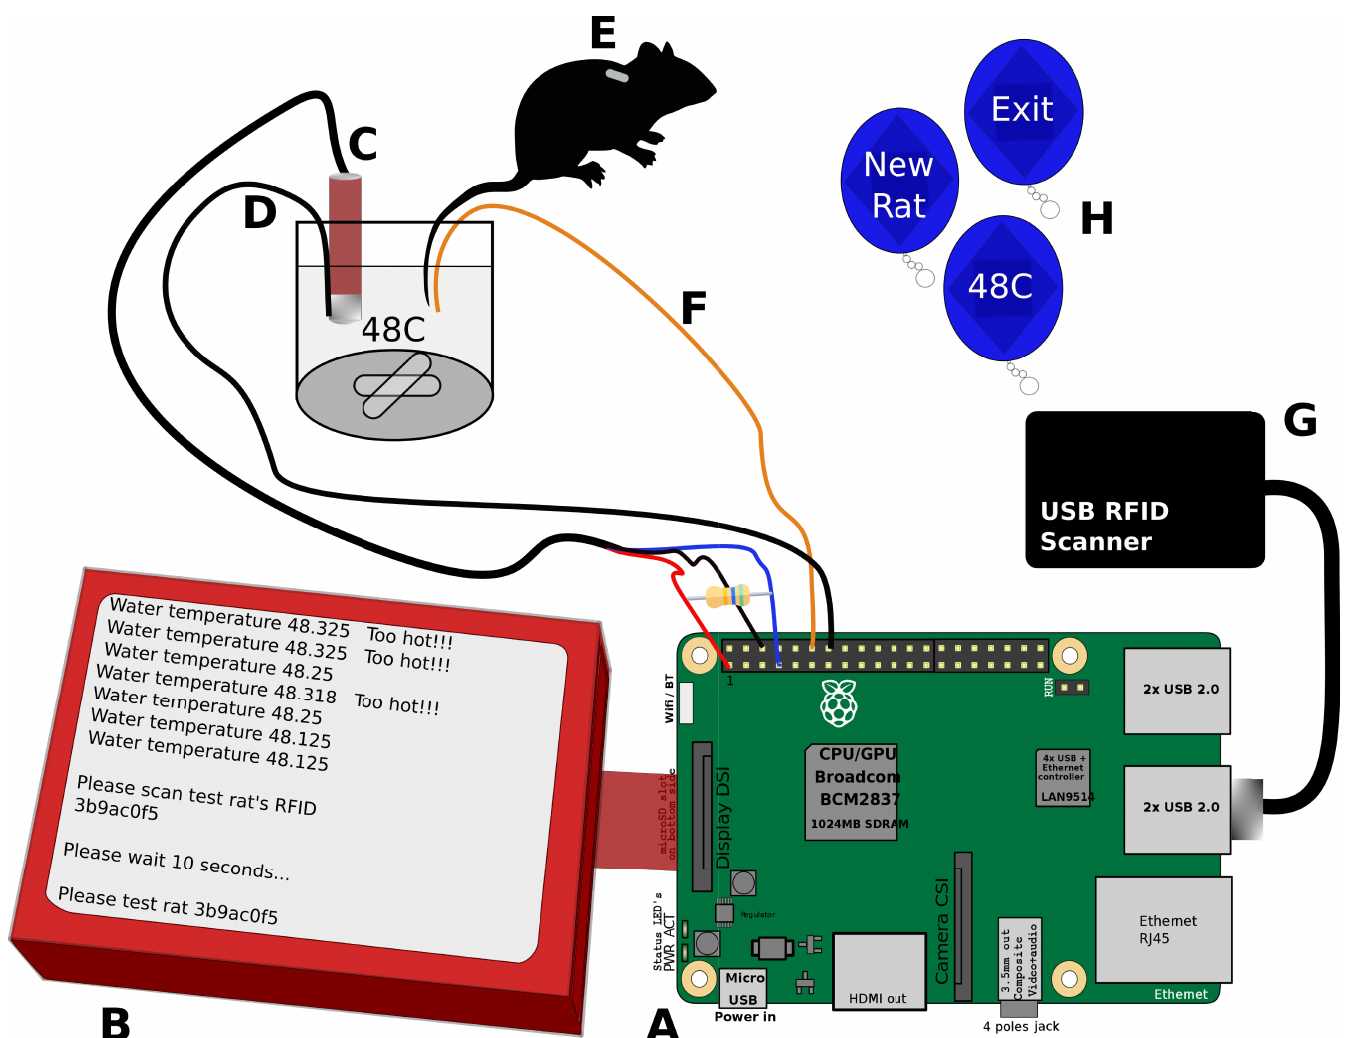
Fig 1. Components of the TailTimer device for use in the tail immersion assay. [ A ] The Raspberry Pi 3 computer. [ B ] The TailTimer software in operation. [ C ] Thermal probe to detect water temperature. [ D ] Electrical ground wire that remains immersed in the water with the thermal probe (C). [ E ] Scannable RFID implanted subcutaneously in the rat for identification. [ F ] Electrical latency wire to be dipped into and withdrawn from the water simultaneously with the rat’s tail to start and stop the timer, respectively. [ G ] USB RFID scanner. [ H ] Scannable RFID command fobs used to navigate the TailTimer program in place of a keyboard and mouse. The six necessary fobs are used to enter the user ID, set the target temperature, start a new rat, test the same rat again, delete the last latency, and exit the program. https://doi.org/10.1371/journal.pone.0256264.g001 waterproof digital temperature sensor (DS18B20, Adafruit Industries, NY, USA), an RFID reader (EM4100, 125 kHz, HiTag, available at Amazon.com), and two electrical wires. All components are enclosed in a 3D-printed case. The connection of the components is illus- trated in Fig 1 and the S1 Photo. The temperature sensor connects to the RP3 via a 1-wire serial interface to provide continuous temperature readings. The RFID reader connects to the RP3 via a USB port. It is used to identify individual rats by scanning the unique RFID chip embed- ded under their skin. The ground wire is connected to one of the ground pins of the general- purpose input/output (GPIO), and the latency wire is connected to GPIO 18 (pin 12). During operation, the ground wire and thermal probe remain immersed together in the hot water at a depth of approximately 4 cm. The latency wire is dipped into the hot saltwater solution at the same time as a rat’s tail and is taken out of the hot water, together with the tail, when a pain